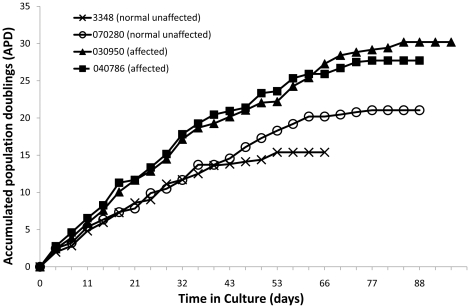
Growth characteristics of skin fibroblasts from ECO-affected and unaffected individuals.The accumulated population doublings (y-axis) achieved at indicated time in culture (x-axis) for four fibroblast cell lines. The fibroblast cell lines include: two homozygous normal subjects (070280 and 3348) and the two homozygous affected subjects (030950 and 040786).